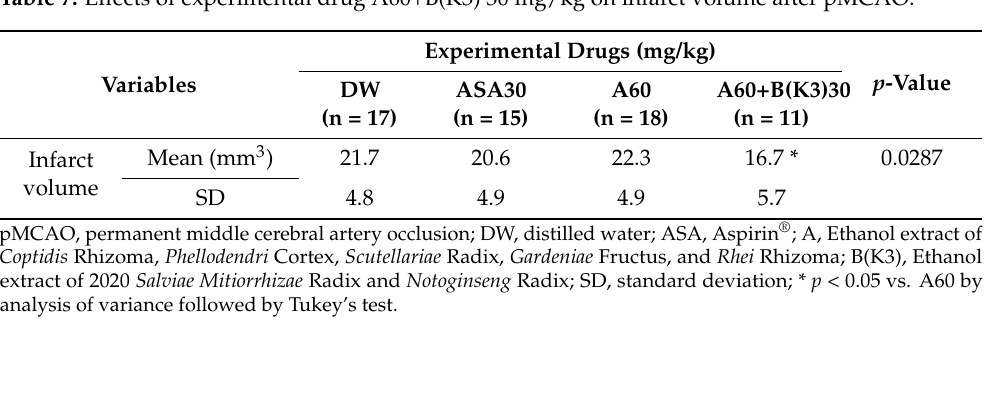
vs. DW; ** p < 0.01 vs. A60 by analysis of va riance followed by Tukey’s test.